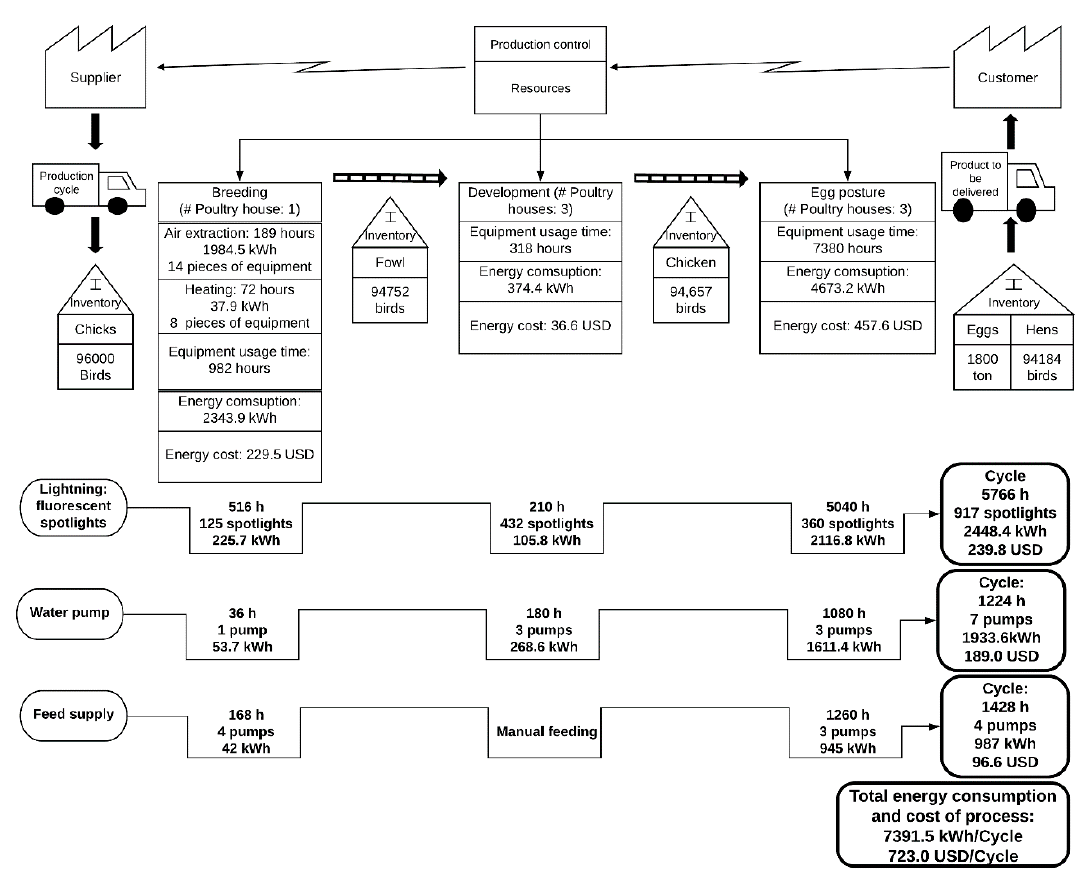
Figure 9. Energy consumption and cost of the expected future scenario of energy flow from unit operations in egg production at a future state.